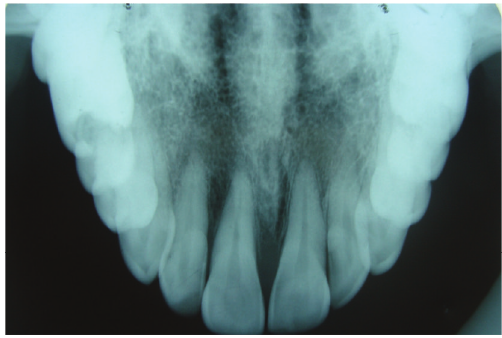
Figure 2: Interdental bone loss in relation to maxillary central and lateral incisors.